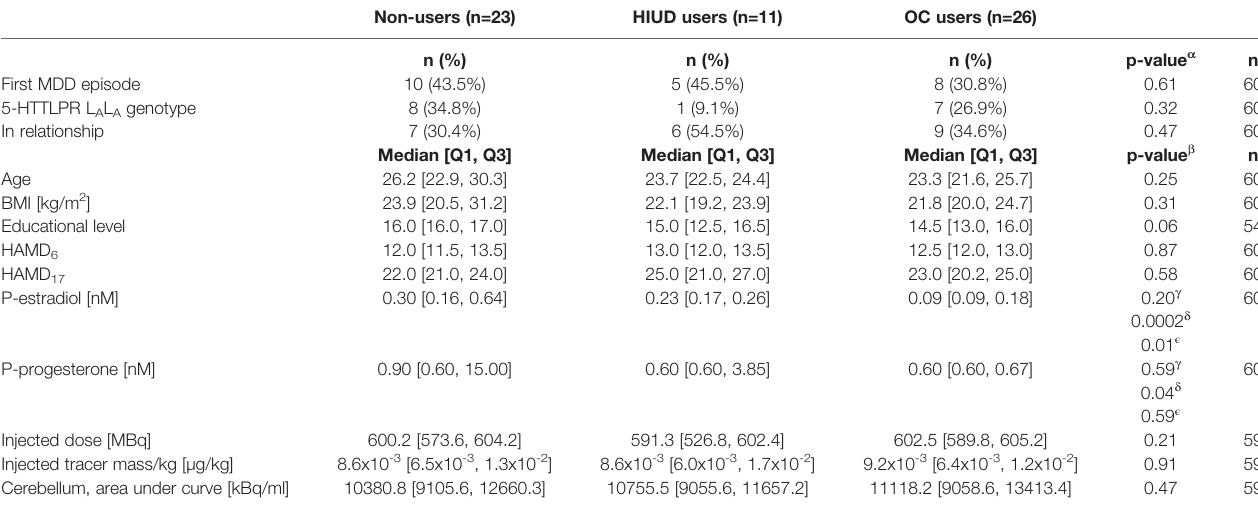
TABLE 1 | Clinical pro fi le and PET parameters at